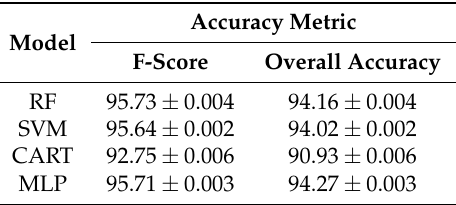
Table 4. Accuracy scores (F1 and Overall Accuracy) from 2 × 5 nested cross-validation showing a comparison of model performance. RF = Random Forest, SVM = Support Vector Machines, CART = Classification and Regression Trees, MLP = Multilayer Perceptron.